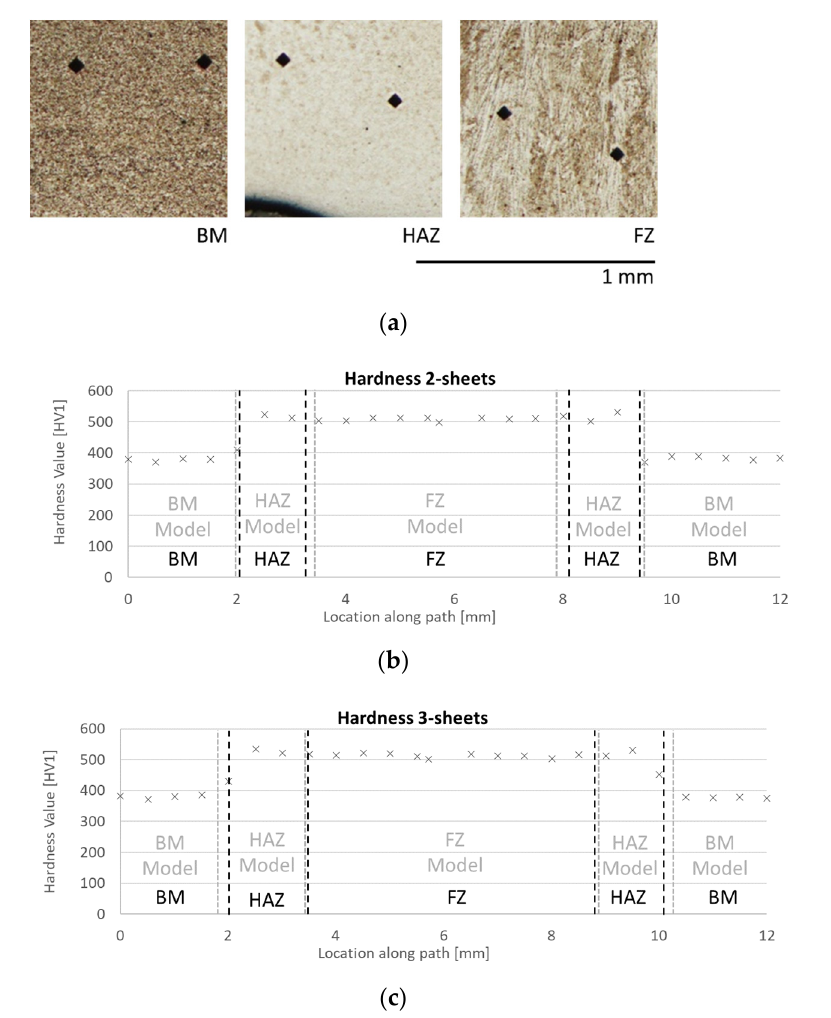
Figure 7. ( a ) Microhardness measurements at different spot weld areas. The microhardness values (indicated by × markers) for the ( b ) 2-sheet stack up and ( c ) 3-sheet stack up in comparison to the respective location of all different metallurgical zones as found by image analysis of the micrographs (indicated in black) and to the zone boundaries predicted by the model (indicated in grey).